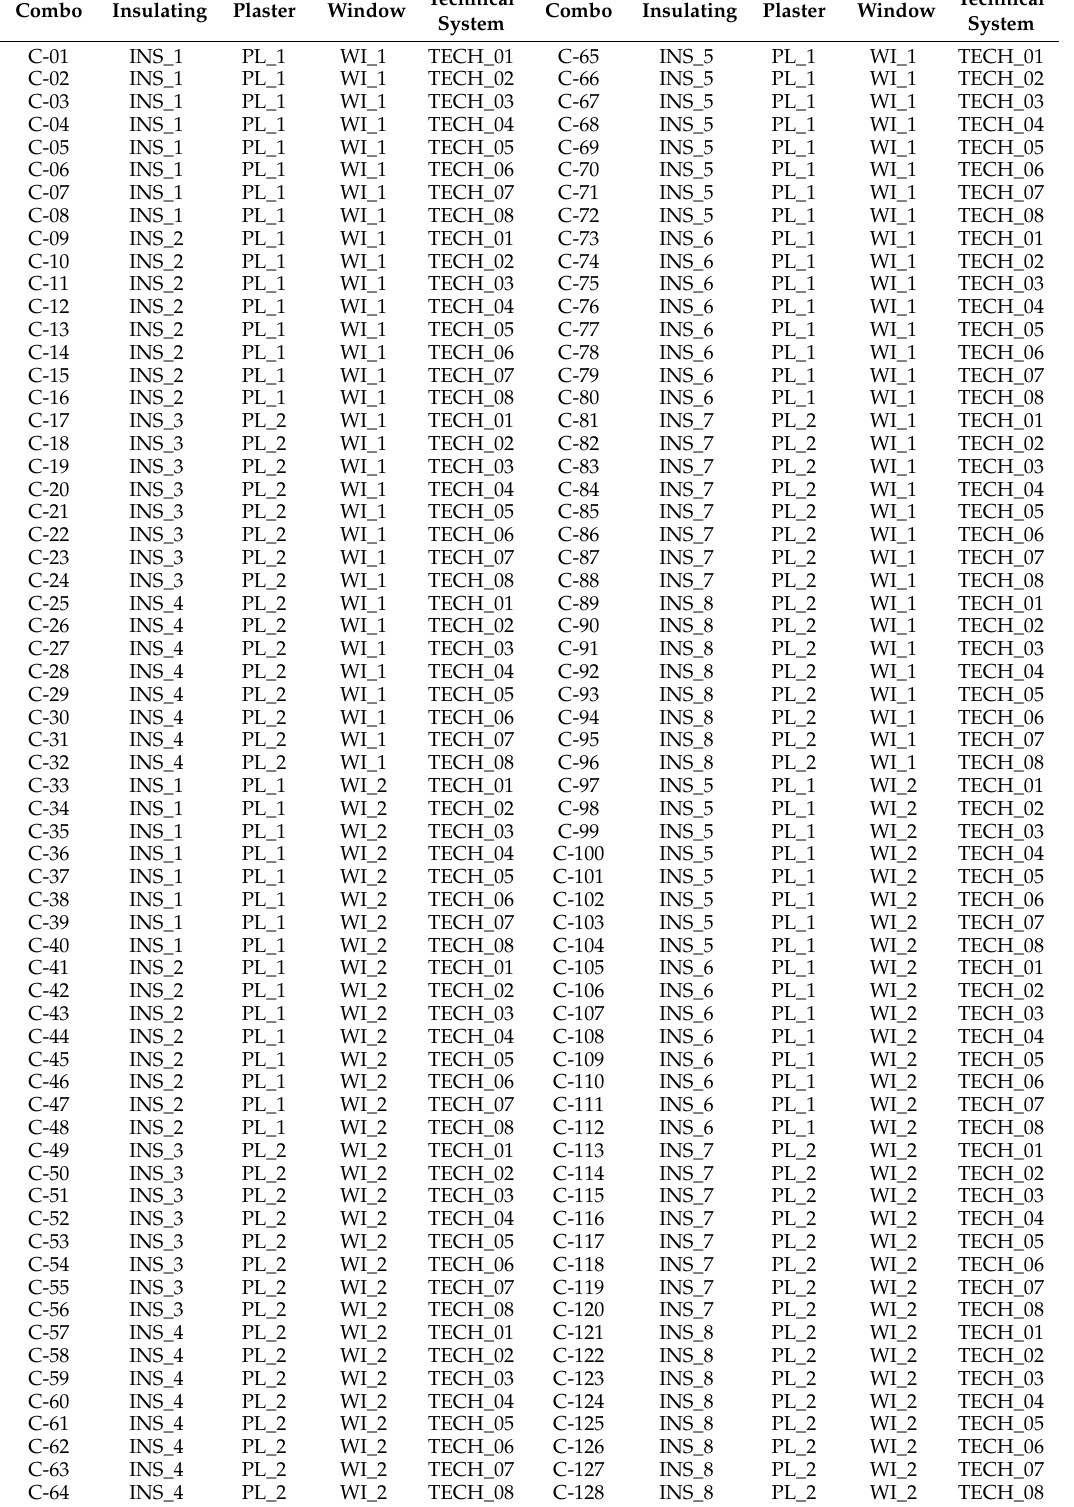
Table 7. Summary description of variants combinations for each block of the reference